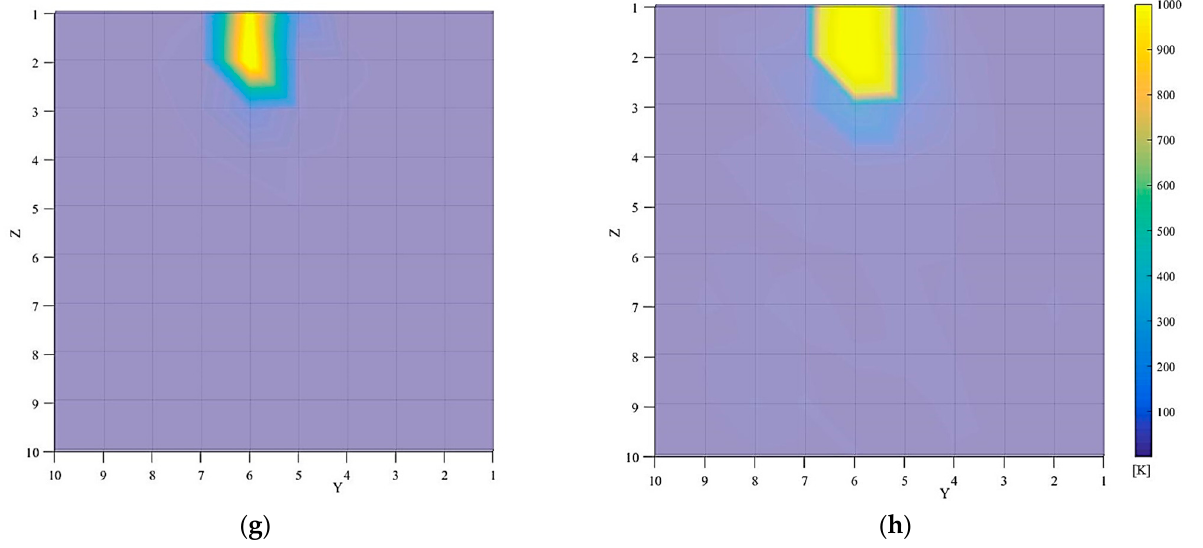
Figure 6. Simulation result when time changes. The red boxes in ( b , d , f ) are added for the visual aid. ( a ) Mineral distribution; ( b ) cross-section surface viewed from y-z direction; ( c ) electric field (50% rise of lightning impulse voltage); ( d ) electric field (100% rise of lightning impulse voltage); ( e ) heat (50% rise of lightning impulse voltage); ( f ) heat (100% rise of lightning impulse voltage); ( g ) variation of temperature (50% rise of lightning impulse voltage); ( h ) variation of temperature (100% rise of lightning impulse voltage).